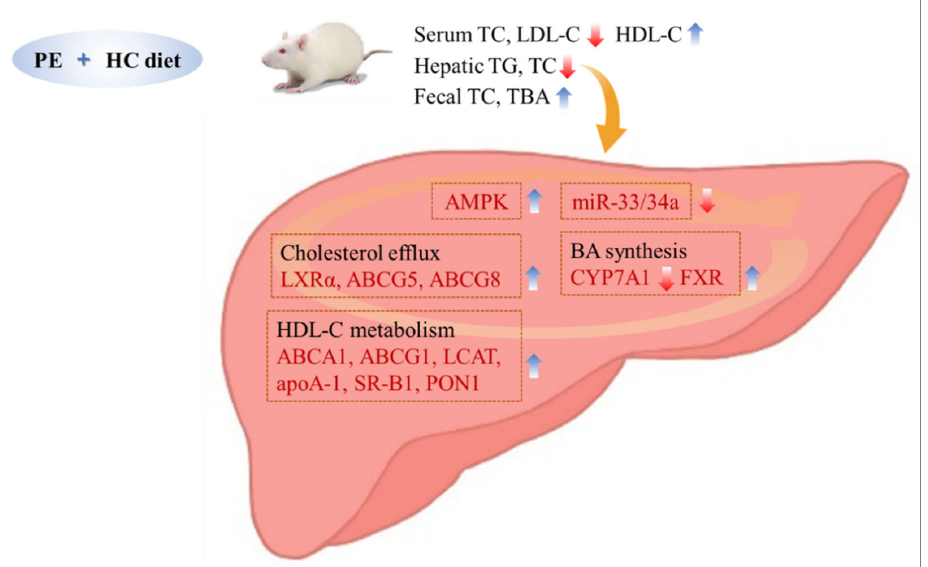
Figure 4. Schematic diagram showing potential regulatory mechanisms in the liver for the lipid- improving effects of PE in rats fed a high-cholesterol diet. HC, high-cholesterol; PE, 0.8% extruded Portulaca oleracea L. extract; ABCA1, ATP-binding cassette subfamily A1; ABCG1, ATP-binding cassette subfamily G1; ABCG5, ATP-binding cassette subfamily G member 5; ABCG8, ATP-binding cassette subfamily G member 8; AMPK, AMP-activated protein kinase; apoA-1, apolipoprotein A-l; CYP7A1, cholesterol 7 alpha hydroxylase; FXR, farnesoid X receptor; HDL-C, high-density lipoprotein-cholesterol; LCAT, lecithin-cholesterol acyltransferase; LDL-C, low-density lipoprotein- cholesterol; LXR α , liver X receptor alpha; miR, microRNA; PON1, paraoxonase 1; SR-B1, scavenger receptor class B type 1; TBA, total bile acid; TC, total cholesterol; TG,